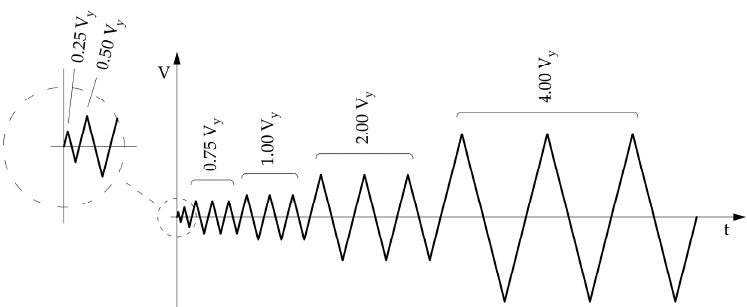
Figure 3. Loading procedure defined by EN 12512 [27] for cyclic tests.